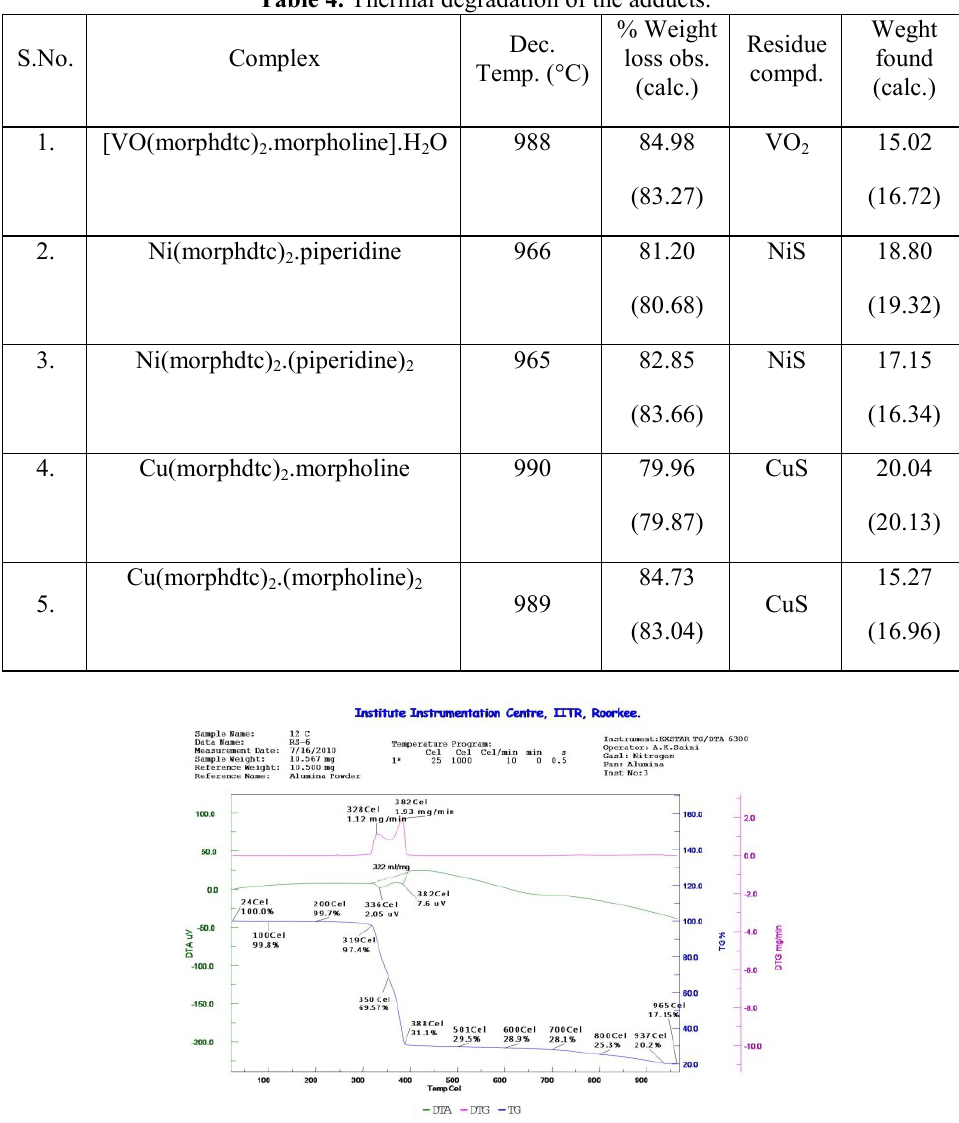
Table 4. Thermal degradation of the